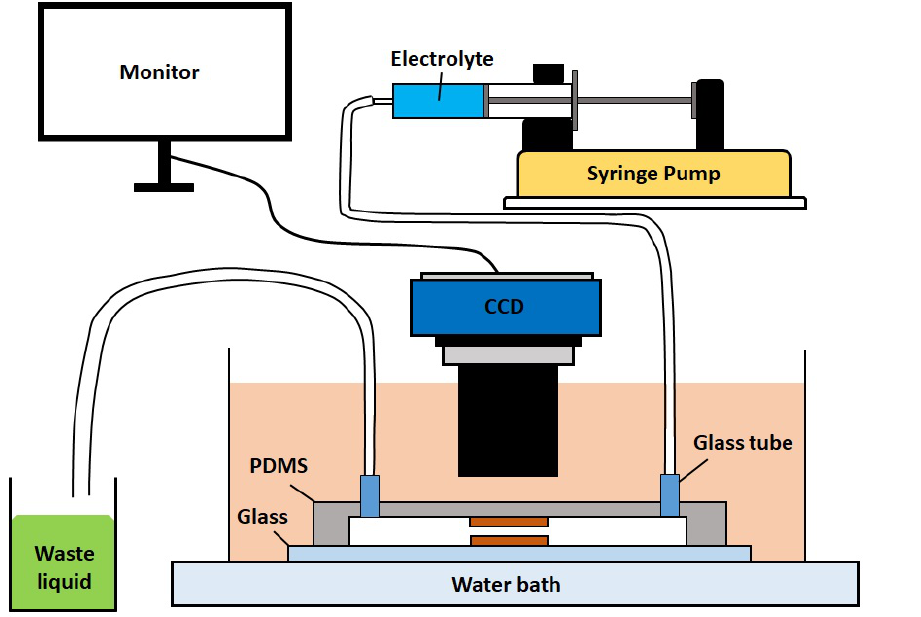
Figure 19. Electroless copper plating via using microfluidic